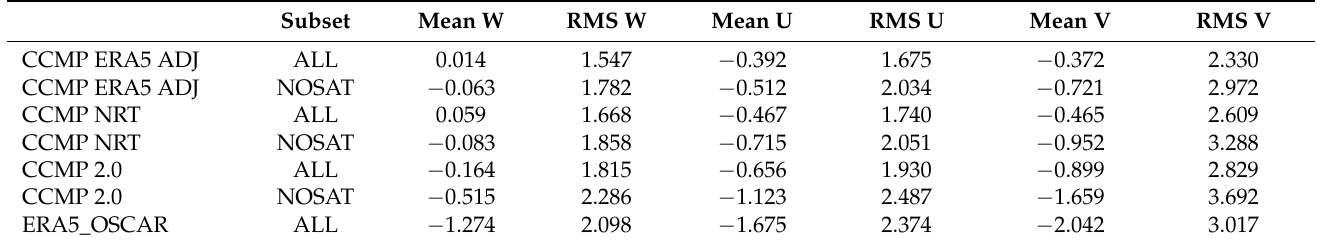
Table 4. Mean and RMS of Wind differences vs. ASCAT-B over all wind speeds > 15 m/s.